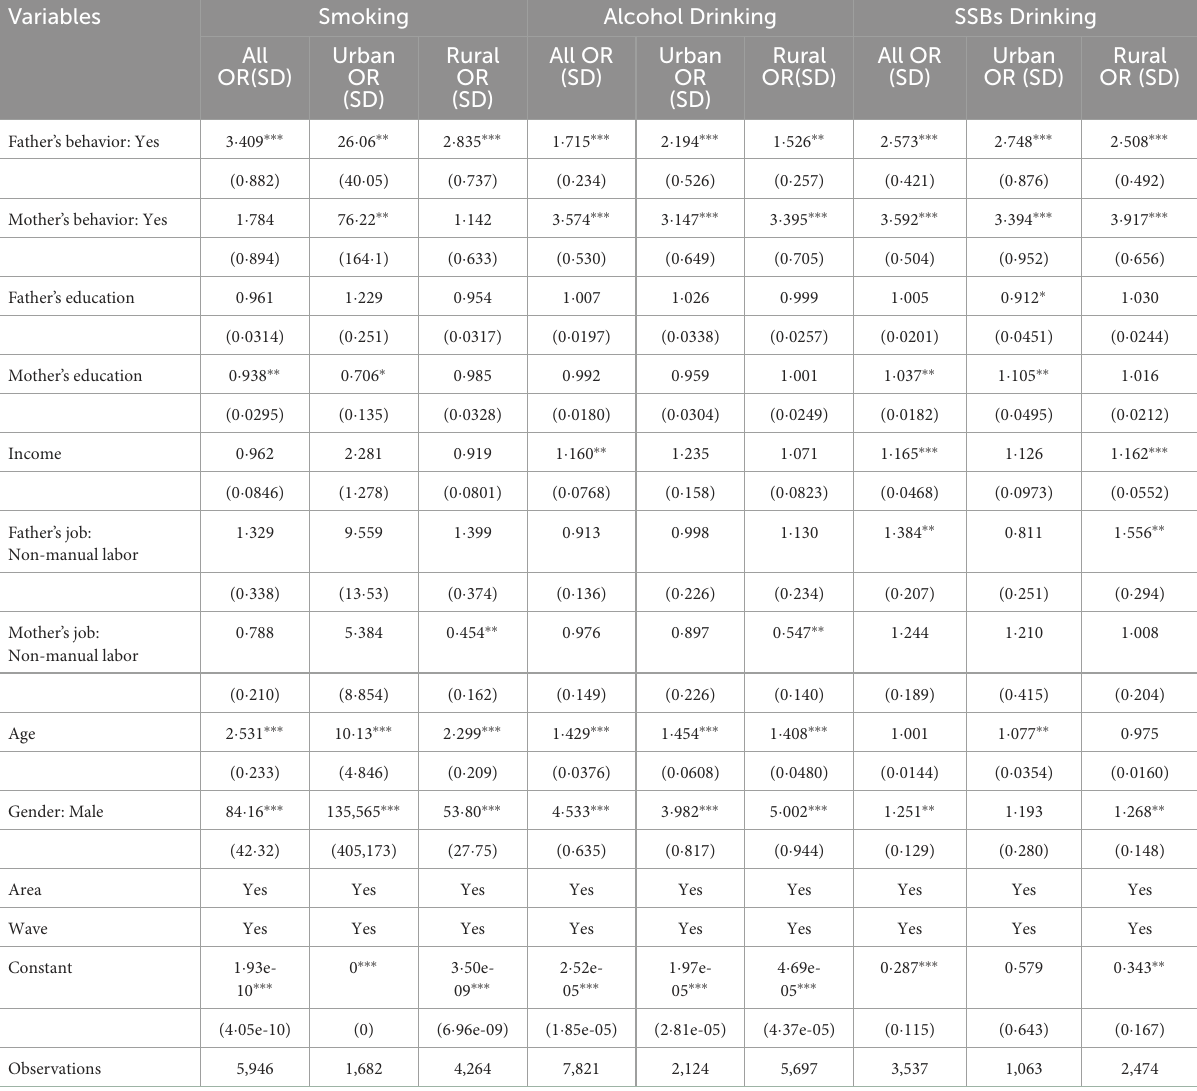
TABLE 2 Results of random-effect logistic regression.